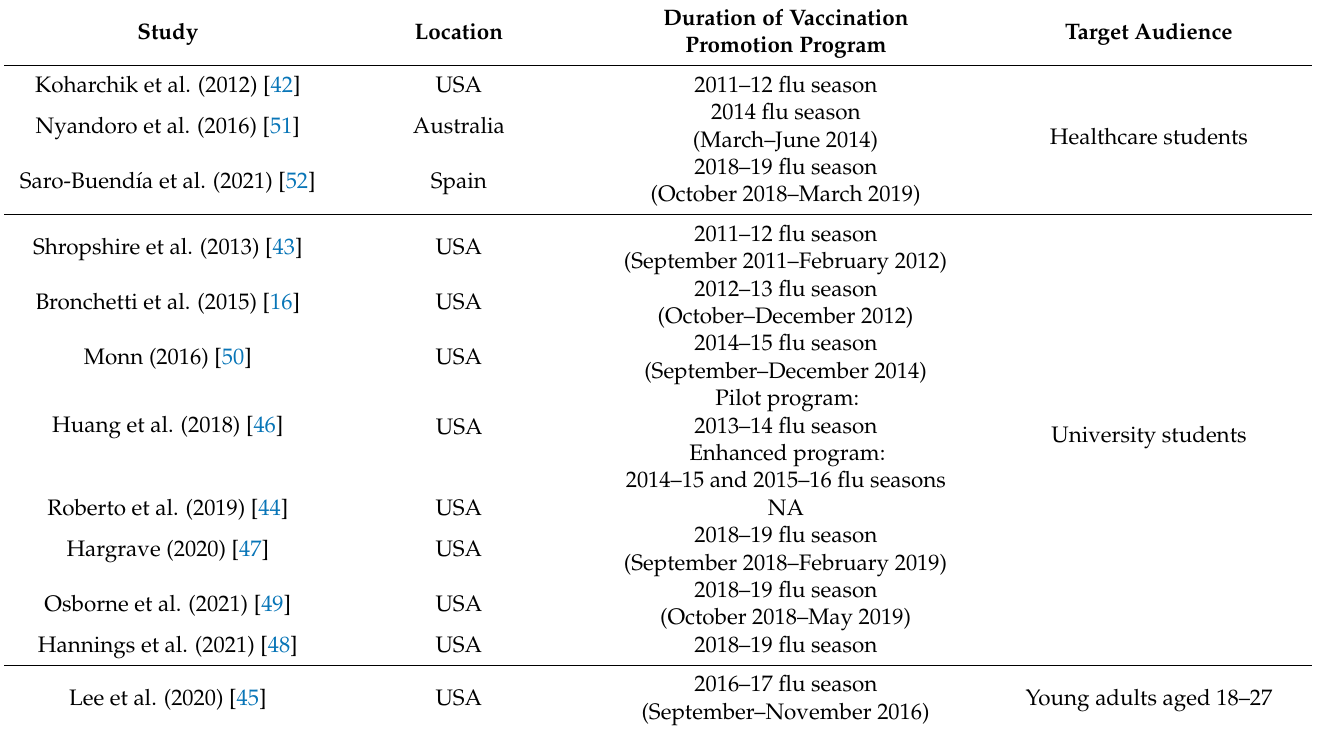
Table 1. Characteristics of included